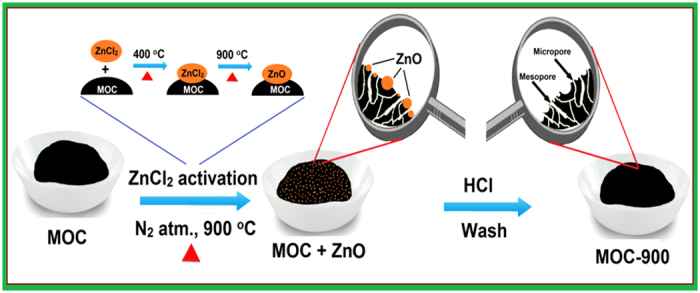
Schematic of the pore formation during activation of MOC at 900 oC in the presence of ZnCl2 as activating agent.